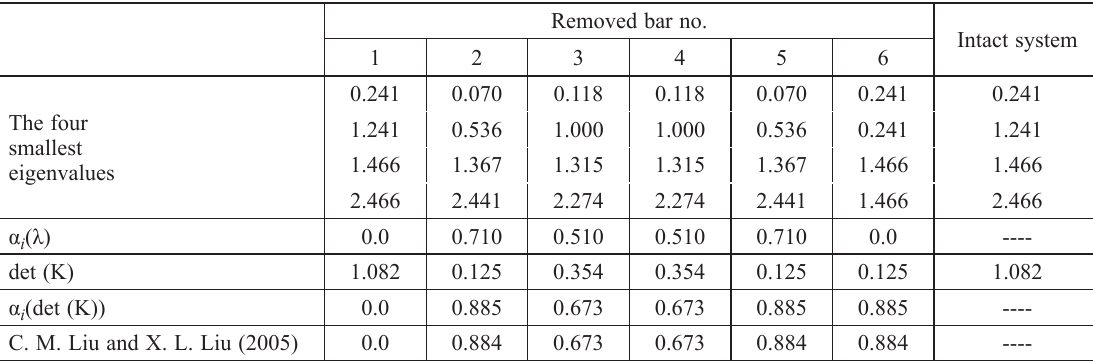
Table 2. Element importance result of the planar